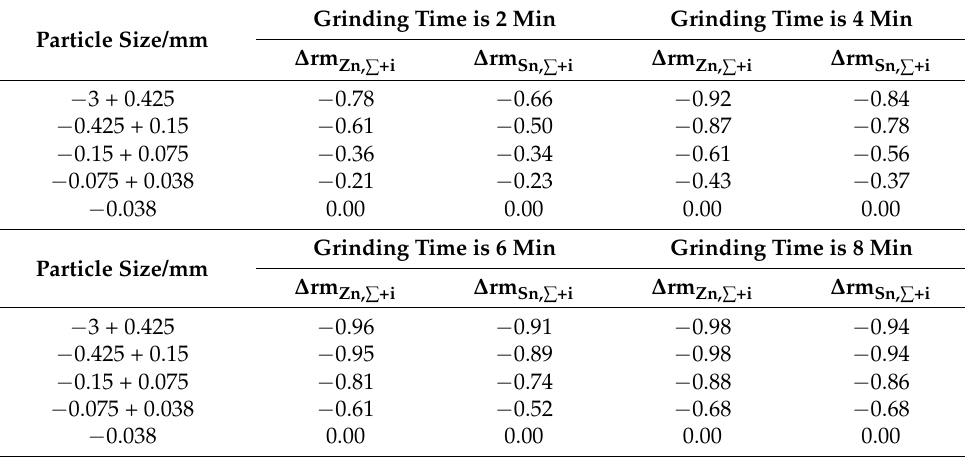
Figure 10. Changes in the cumulative quantities of metal for Zn and Sn for various size fractions for different grinding times when the mill speed is 85 r/min. ( a ) Grinding time is 2 min. ( b ) Grinding time is 4 min. ( c ) Grinding time is 6 min. ( d ) Grinding time is 8 min. Table 11. Changes in the cumulative quantities of metal for different grinding times when the mill speed is 85